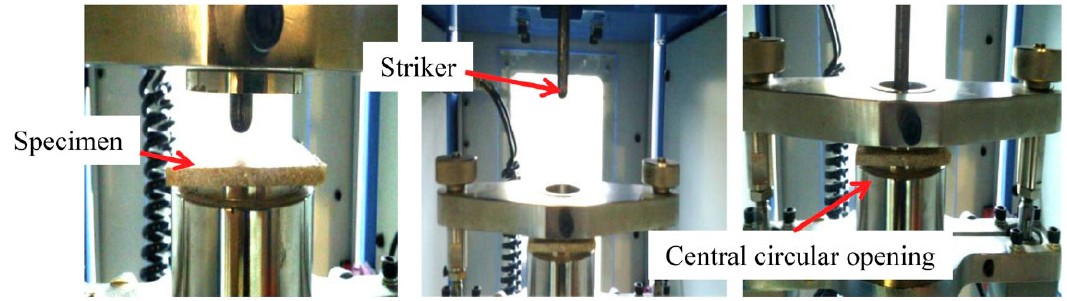
Figure 1. Specimen held and clamped during the drop impact tests.